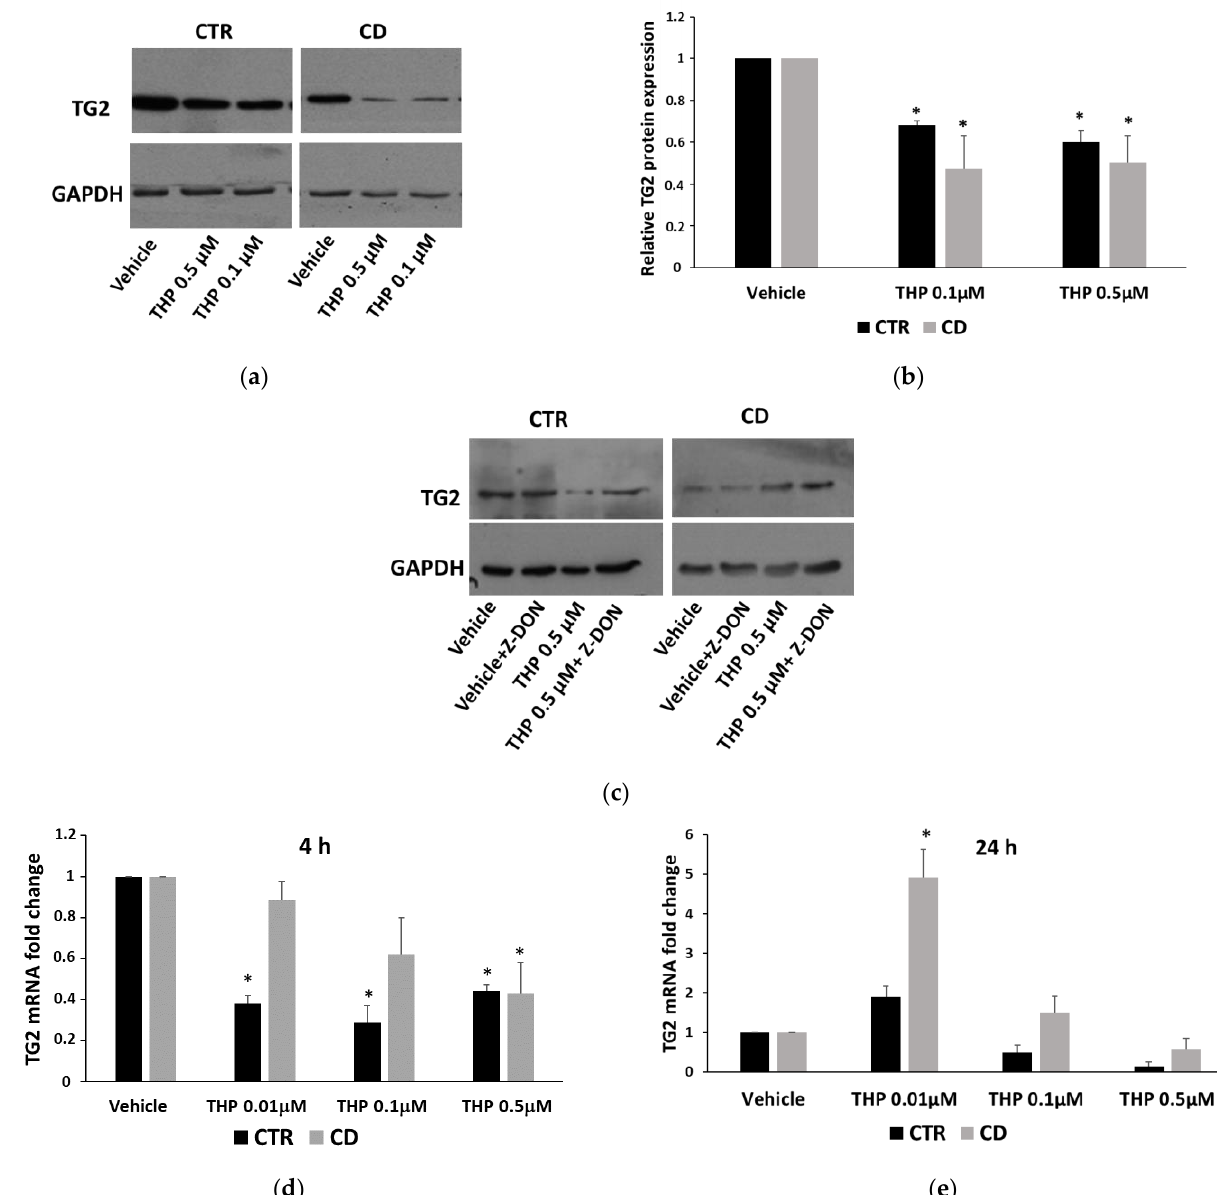
Figure 10. Enzymatic activity of intracellular TG2 expressed as absorbance at 450 nm in skin-derived fibroblasts from three controls and three CD subjects. Data are reported as mean ± SE. * p < 0.05 versus respective untreated samples.